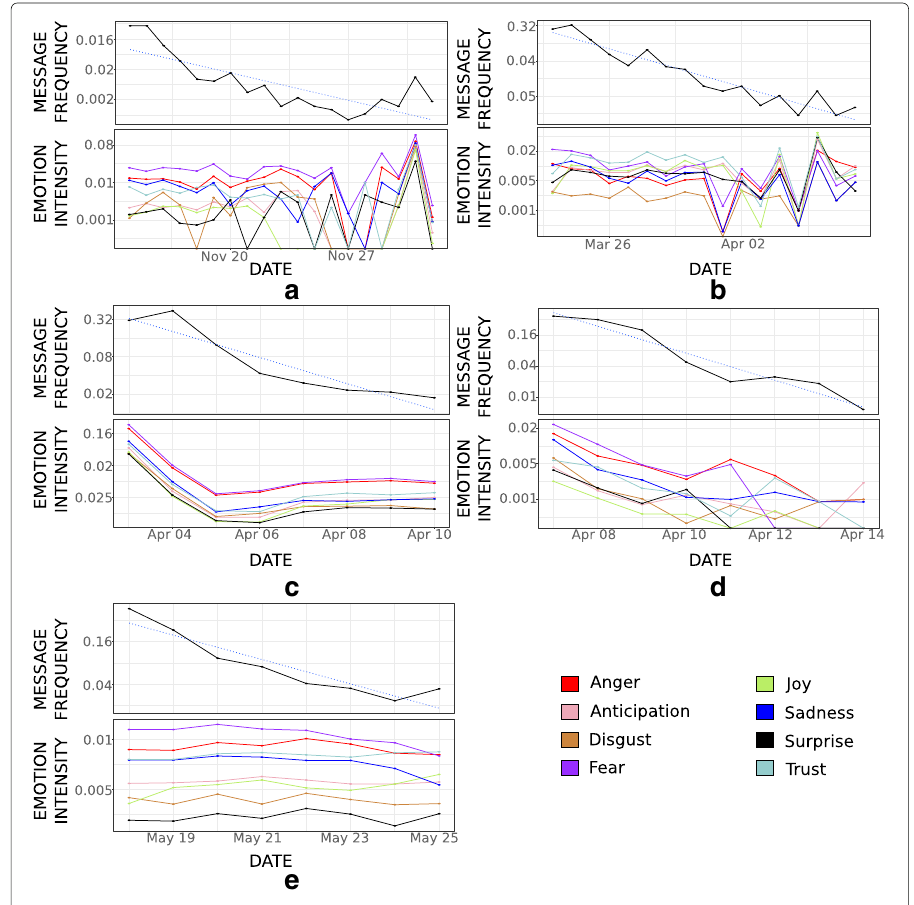
Fig. 6 Temporal flow of direct messages (@-mentioning) and emotions. Number of direct messages per day (message flow frequency) is normalized within the interval [0,1] and plotted with its corresponding regression line (dashed blue line). Daily emotion intensity is averaged over the total number of direct messages per day. a Tehama County shooting b Trebes supermarket siege c YouTube shooting d Münster